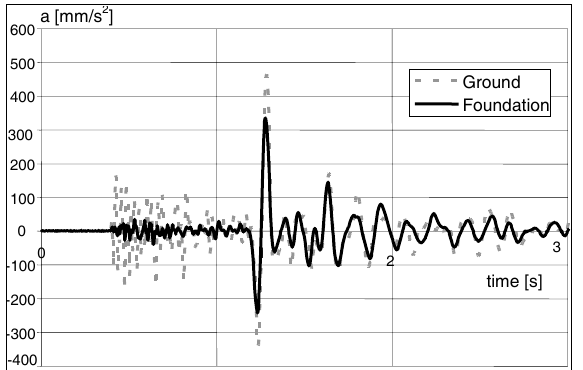
Fig 6 . Diagram of acceleration – Polkowice 13-01-2000